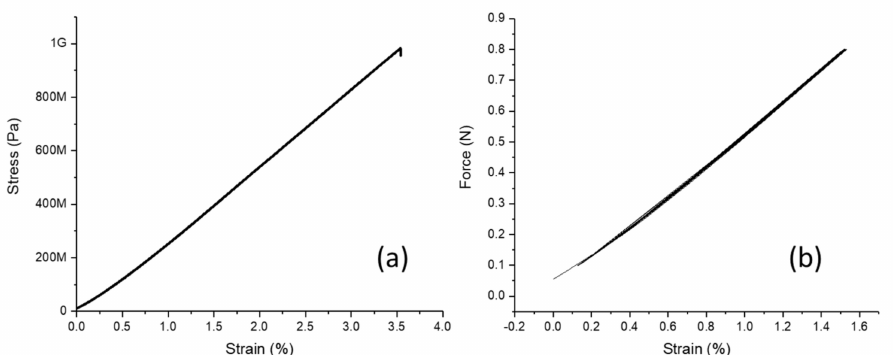
Figure 7. ( a ) Stress–strain curve of a free-standing sample of FeCuNbSiB alloy until breaking. ( b ) Continuously plotted force strain curve of a free-standing sample of FeCuNbSiB alloy that underwent 50 cycles of force applications between 0.1 and 0.8 N.